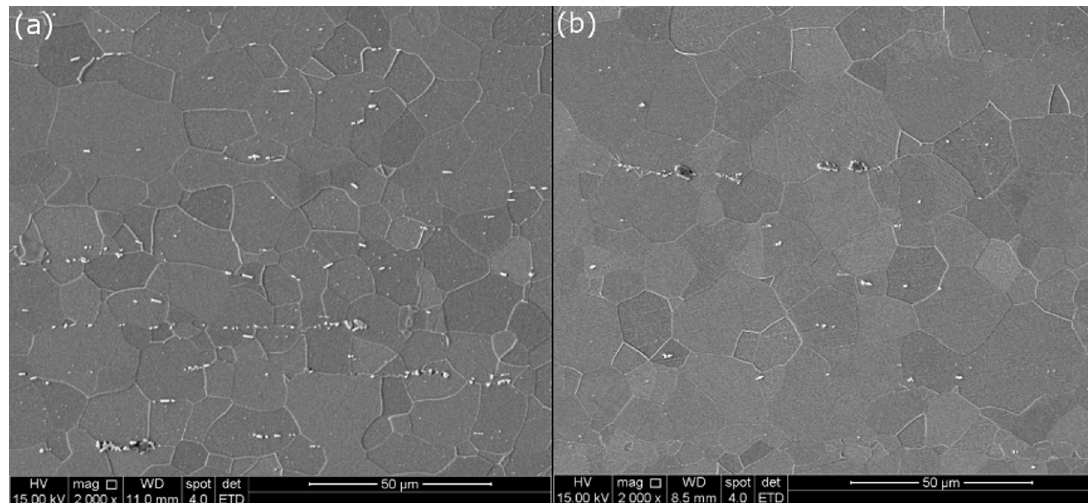
Figure 5. Precipitates of the annealed specimens (a) 430Nb A (b) ASTM 439 A. 15